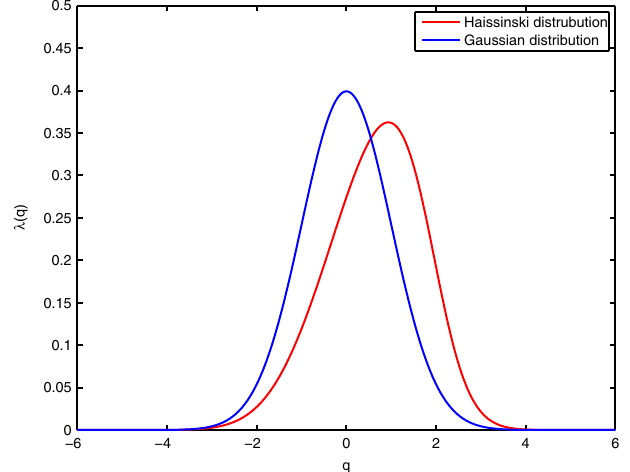
FIG. 1. Comparison of Haissinski distribution at the threshold ¼ 0 : 042 pC = V in the SLC damping ring to a current I th n Gaussian